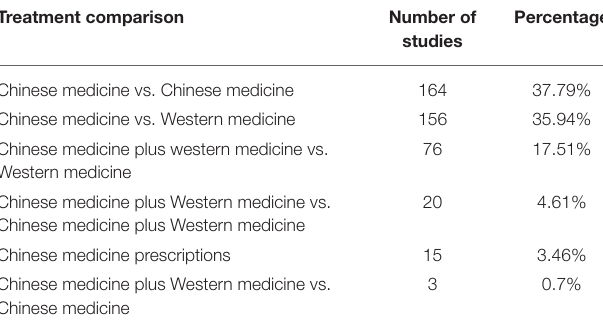
TABLE 1 | Number of studies making different types of comparisons between Chinese and Western medicine ( N = 434). Treatment